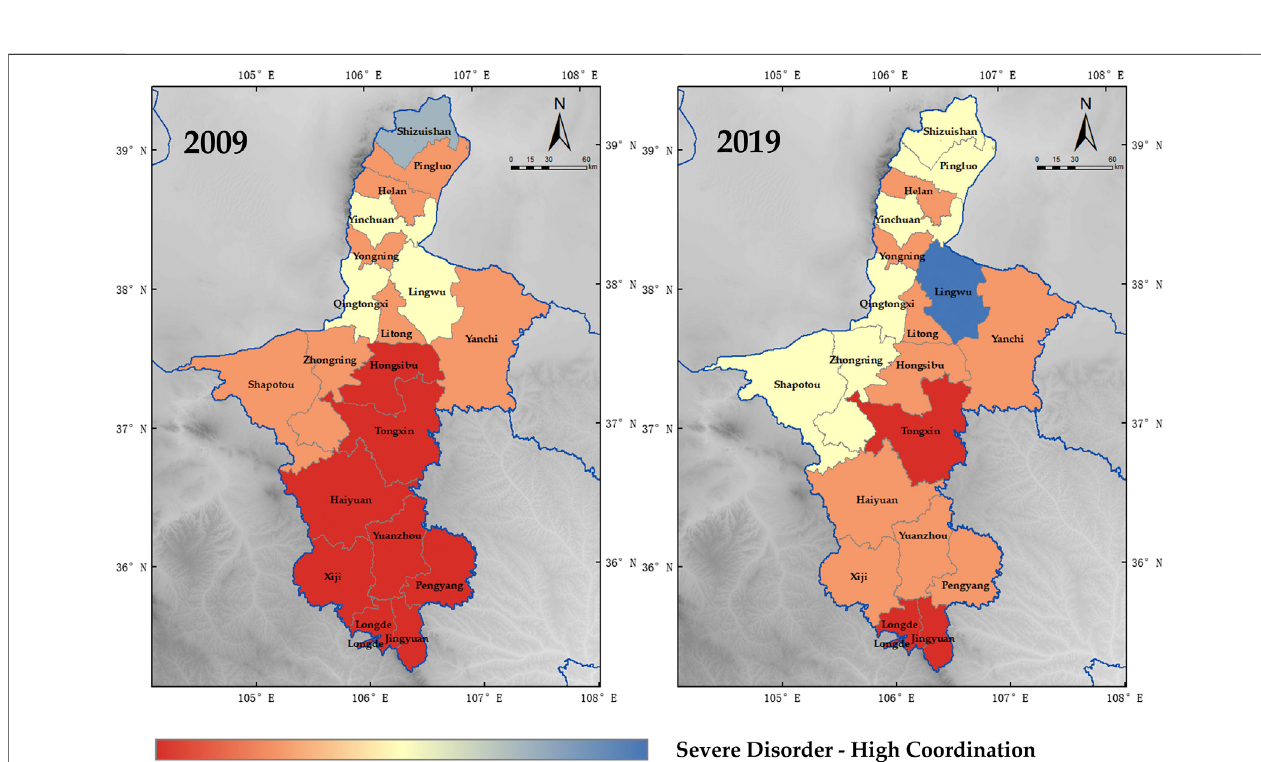
FIGURE 8 | Degree of coupling coordination between urbanization and land use carbon emissions in Ningxia from 2009 to 2019.